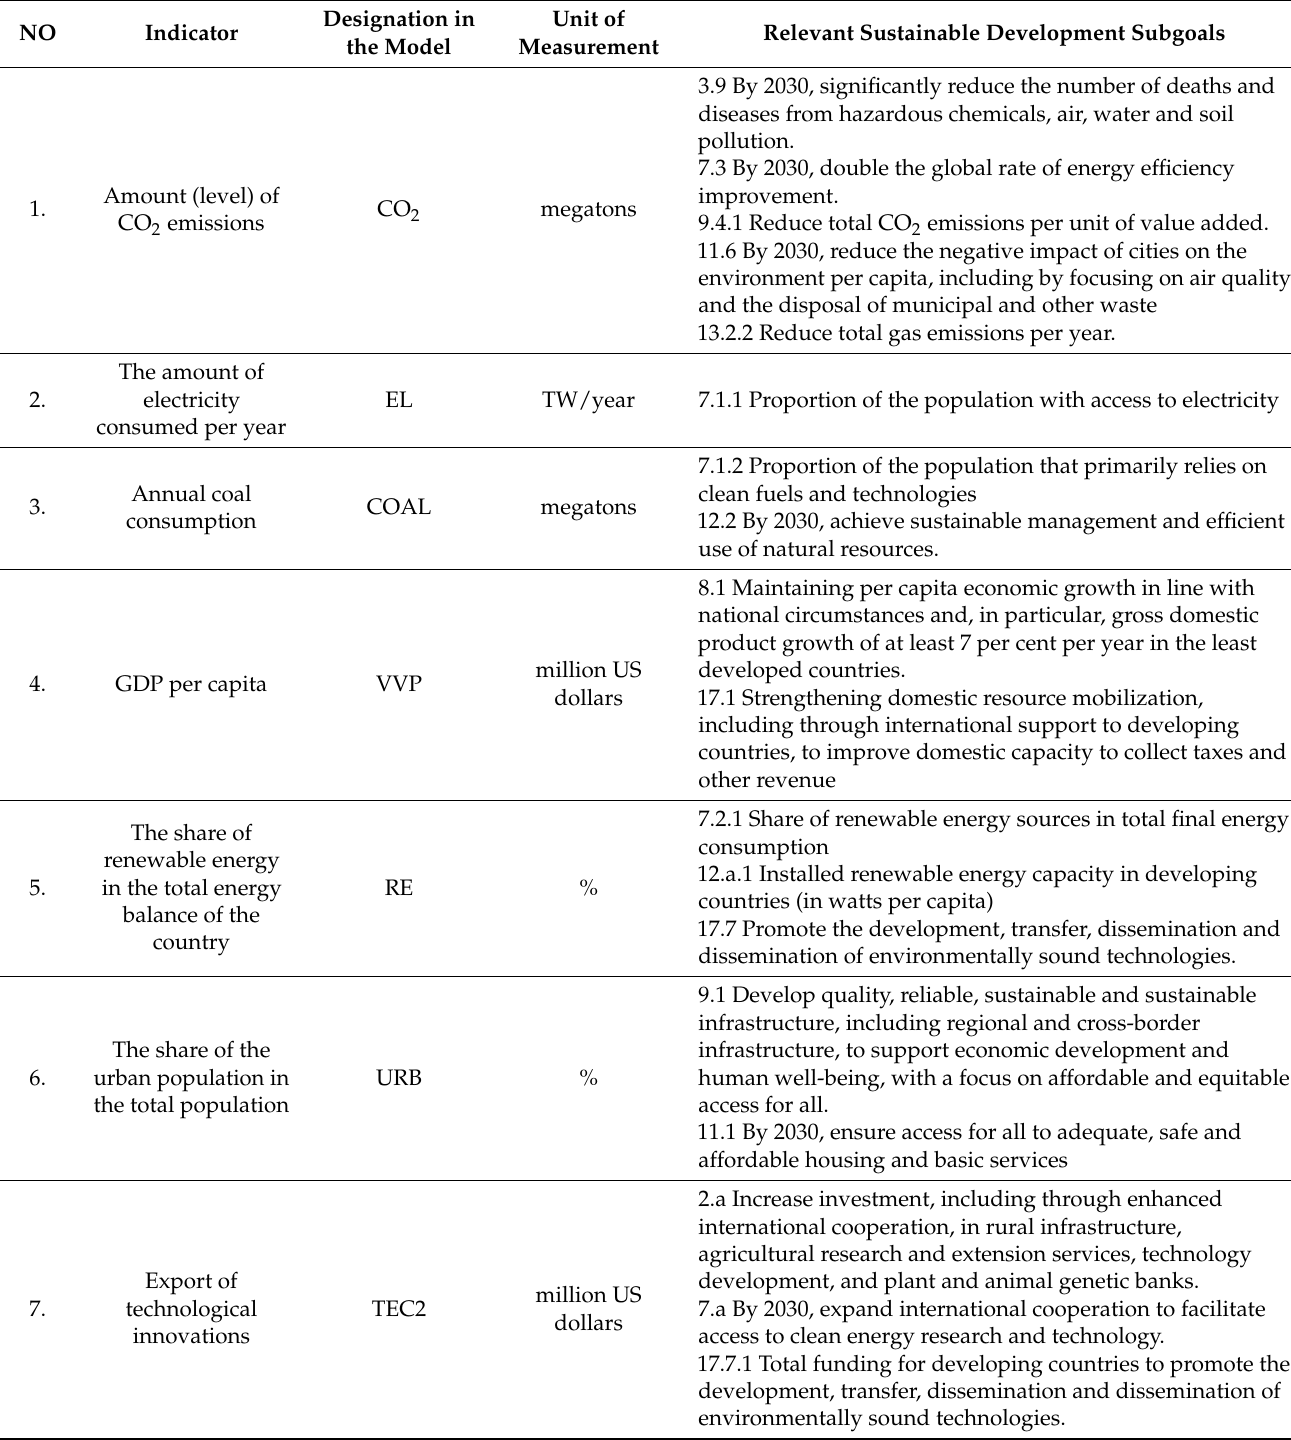
Table 2. List of factors